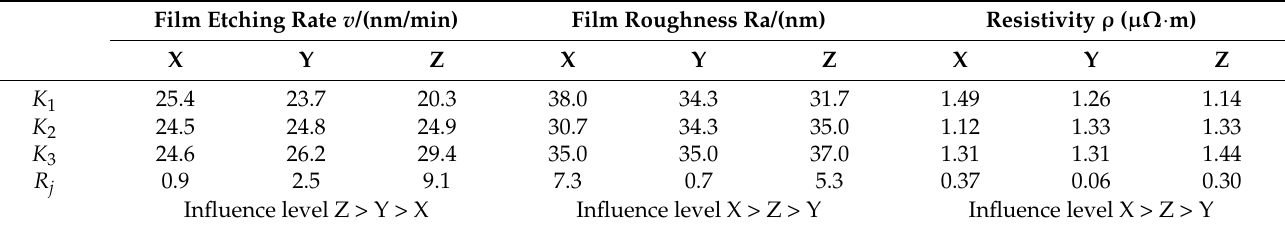
Table 13. Range analysis of thin-film etching experiment